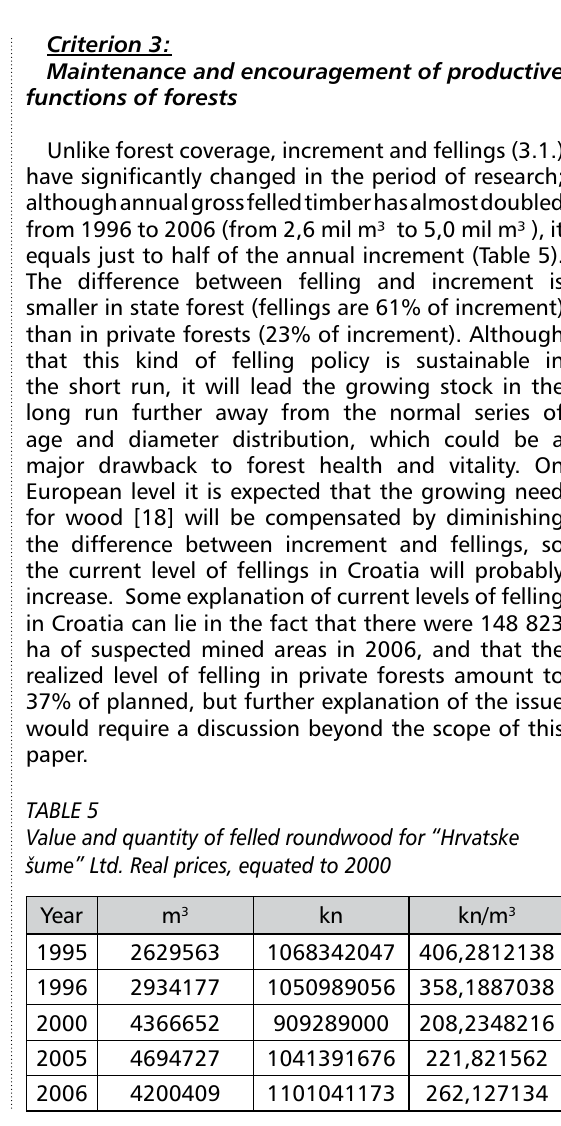
Percentage of trees with more than 25% crown defoliation